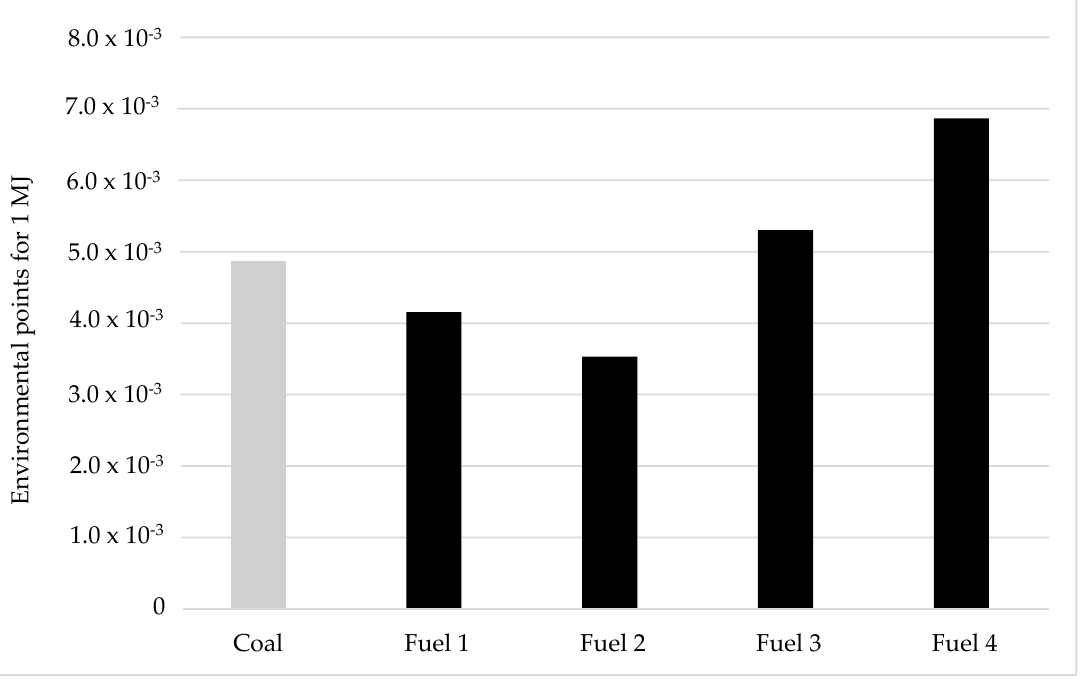
Figure 2. The total burden for the environment expressed in environmental points for 1 MJ of obtained energy.